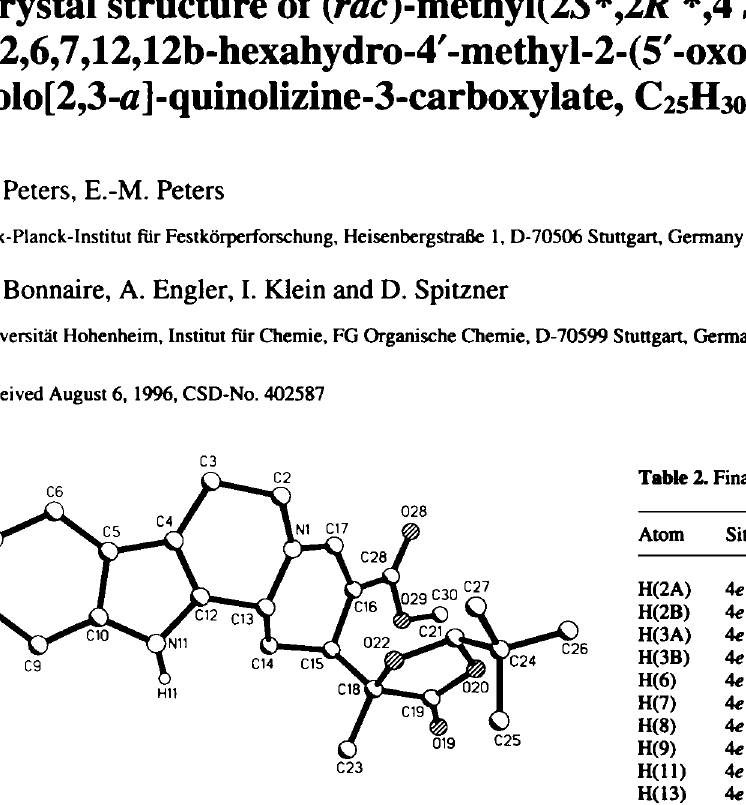
Source of material: The title compound was formed from deproto- nated (2S*,5S)-2-ferf-butyl-5-methyl-l,3-dioxolane-4-one (see réf. 1) and 3-methoxycarbonyl-l-tryptophylpyridinium bromide using the Wenkert protocol (see ref. 2).